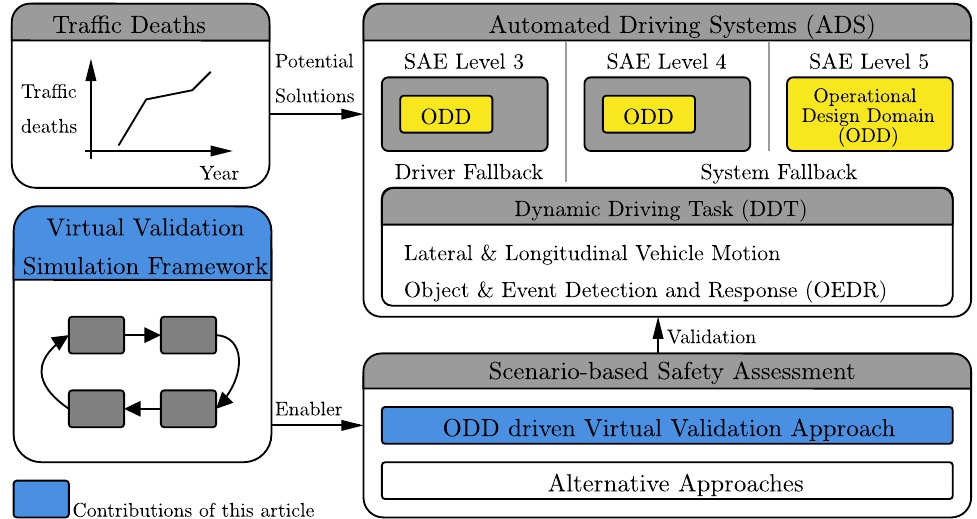
Figure 1. Overview of the relation between the concepts introduced in Section